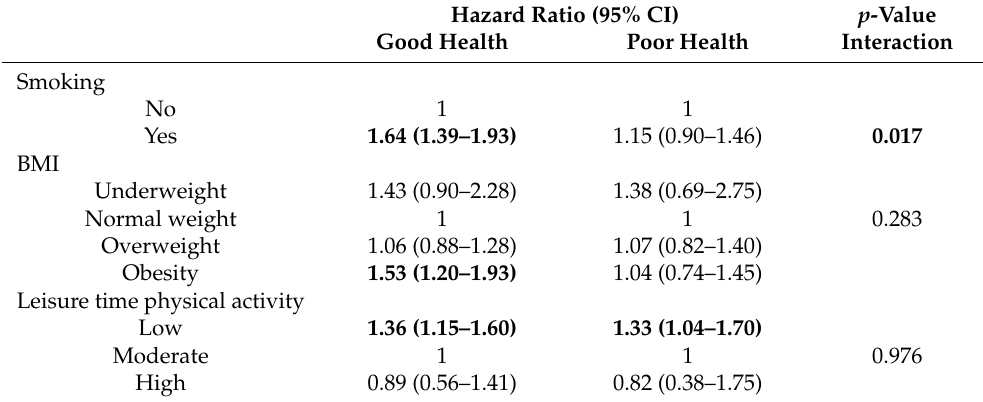
Table 3. Health-stratified analyses of the health-related